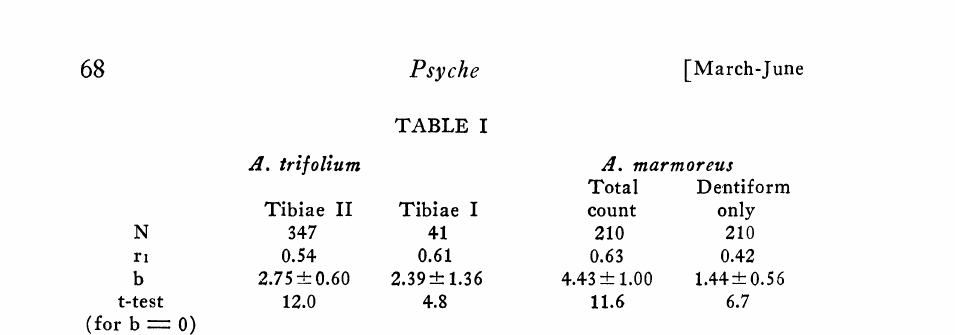
1. trifolium ,4. marmoreus